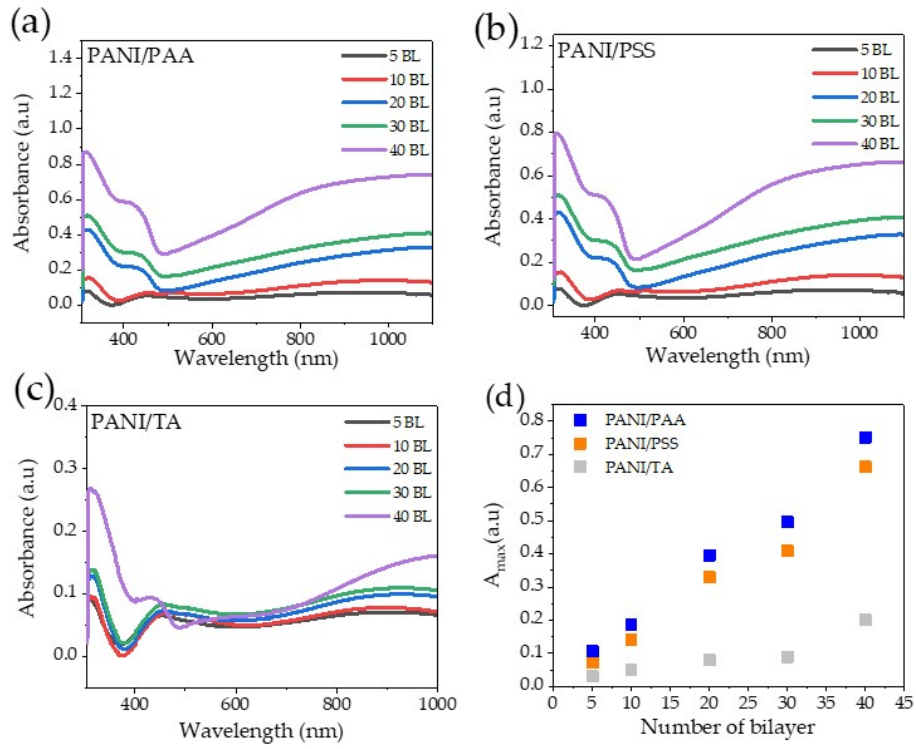
Figure 2. UV–Vis spectra of: ( a ) PANI/PAA, ( b ) PANI/PSS, and ( c ) PANI/TA LbL films and ( d ) their plot of maximum absorbance (~840 nm) as a function of the number of bilayers.